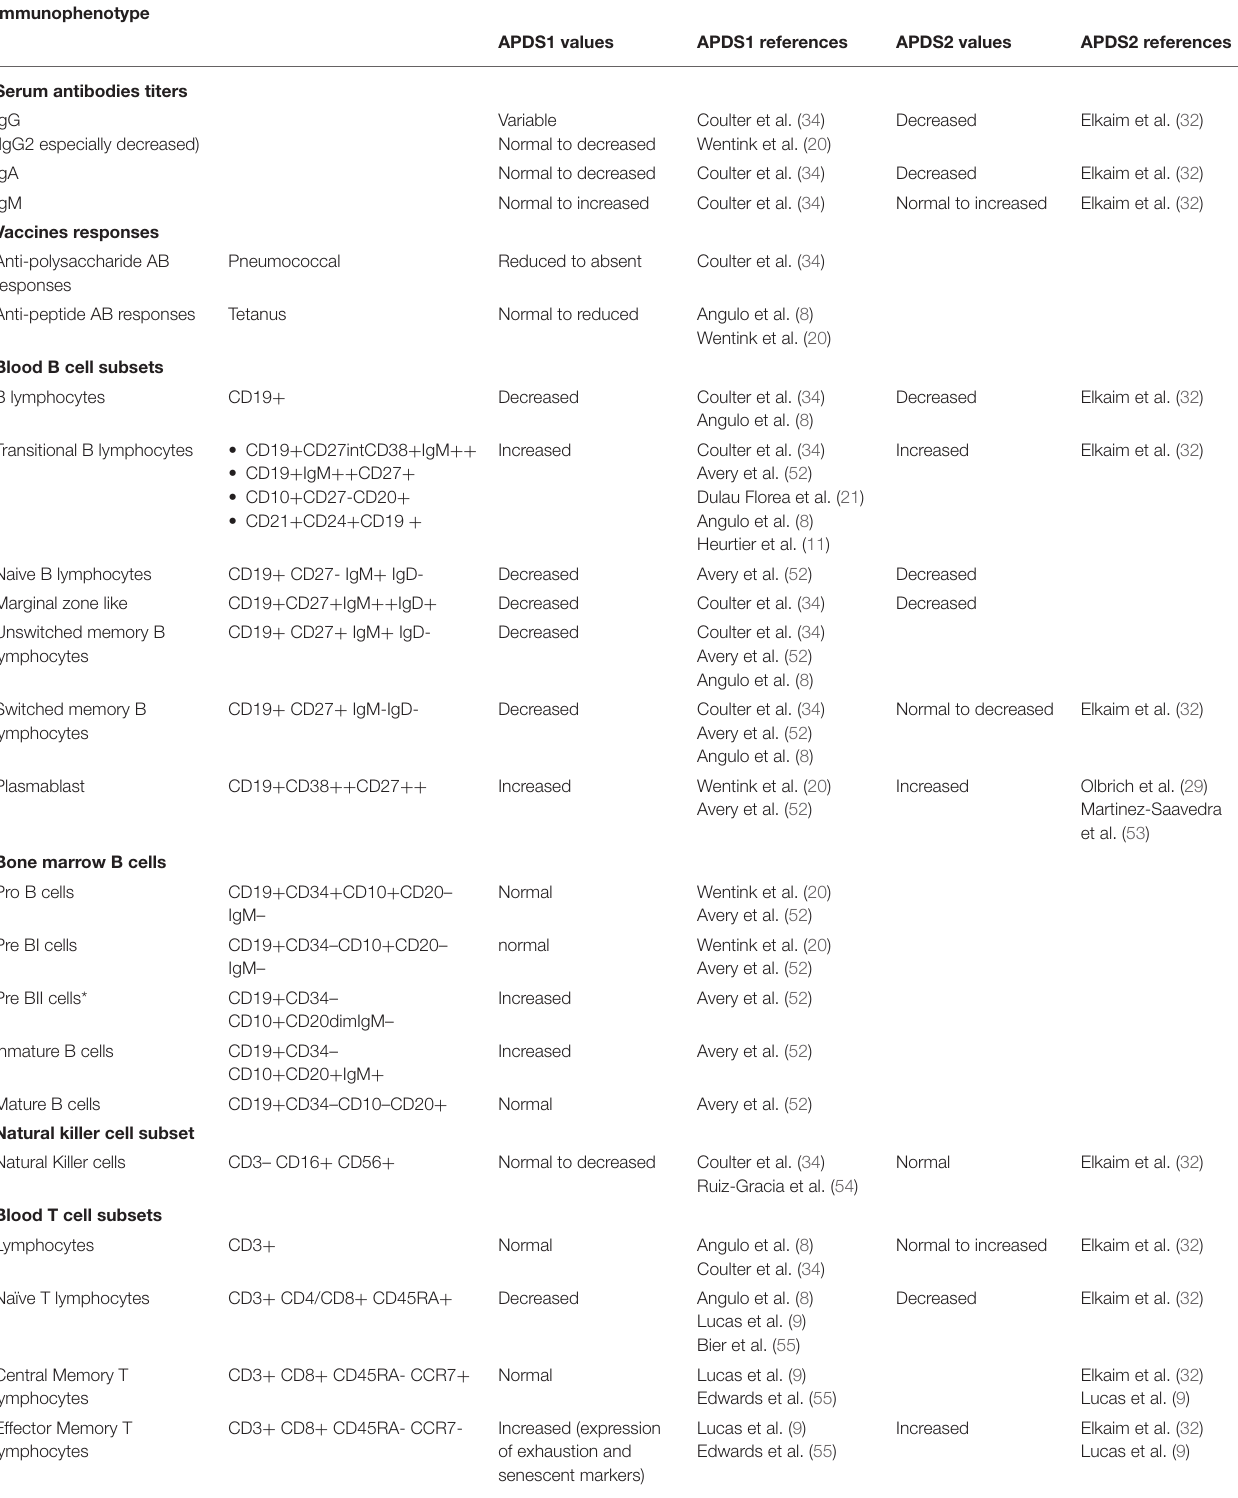
TABLE 2 | B and T lymphocyte dysfunction in